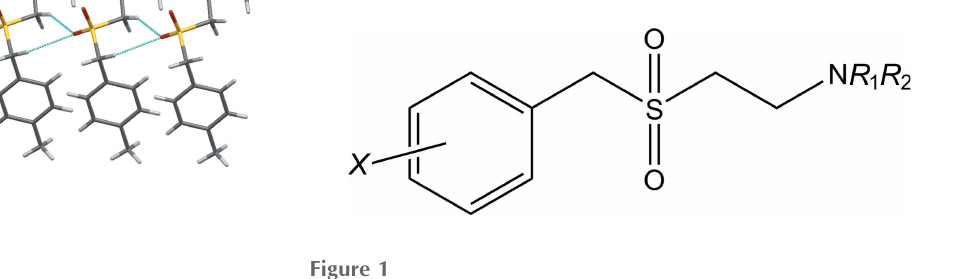
Figure 1 General structure of sulfone analogues. R represents alkyl chains and X represents halogen